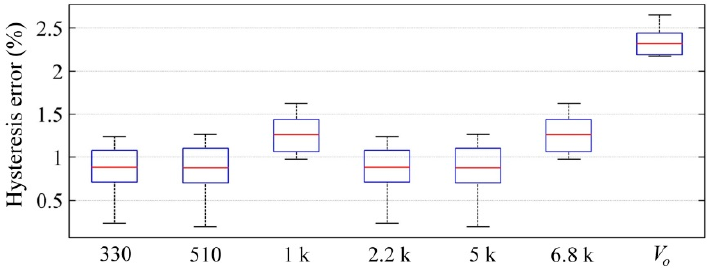
Figure 8. The box plot of the hysteresis error obtained from the authors’ proposed circuit in Figure 3, and the manufacturer’s recommended method in Figure 5. The x-axis of the plot represents the offset resistances employed during each test with R 1 = R 2 and the traditional method ( V o ).